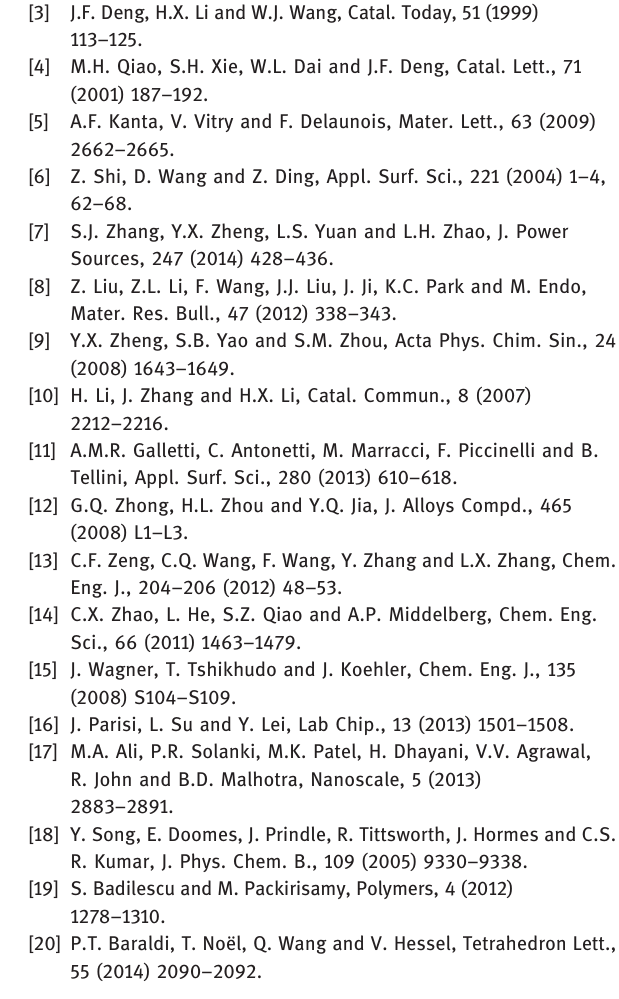
Figure 5: Full range XPS spectrum of Ni-B amorphous nanoparticles (A) and XPS spectrum of the Ni 2p3/2 core level region of Ni-B amorphous